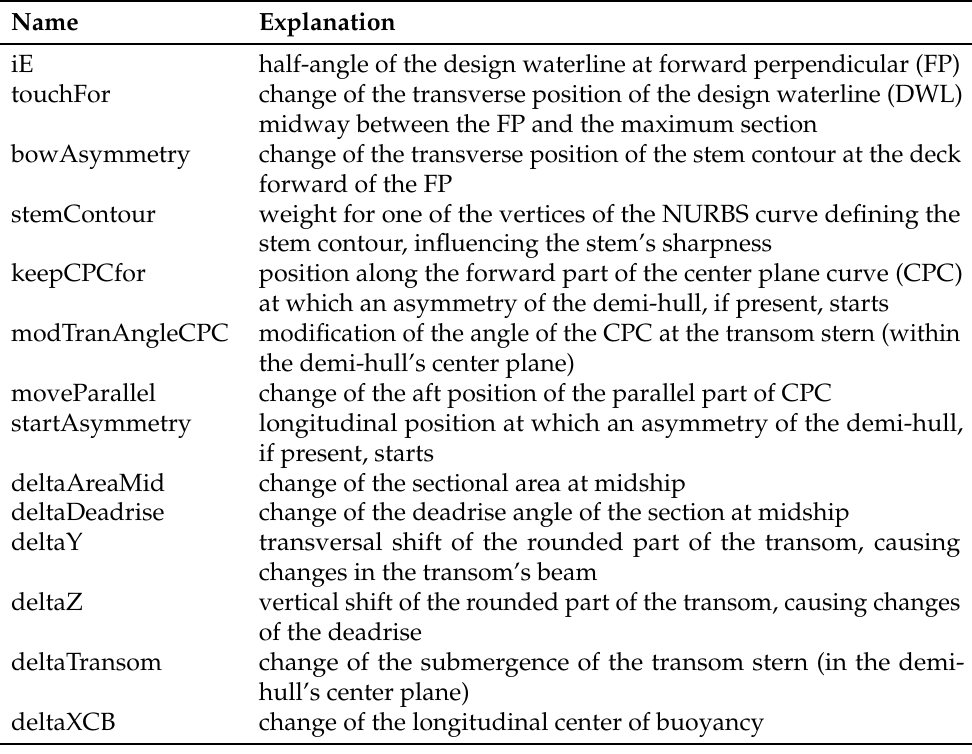
Figure 9. Resulting geometry of the cat’s demi-hull for target curves with minimum and maximum values of free variables. Table 2. Design variables in CAD space used for